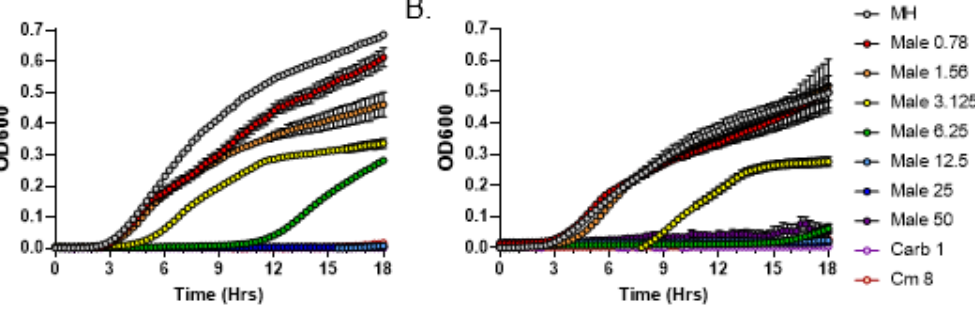
Figure 2. Broth microdilution method to determine the Minimal Inhibitory Concentration (MIC) of metabolites present in C. purpureus R40 exudates. Exudates from two-week-old ( A ) and four-week-old ( B ) C. purpureus R40 strains were tested in MIC assays against S. aureus ATCC25923. Growth curve of S. aureus cells was monitored in the presence of 0.781, 1.56, 3.125, 6.25, 12.5, 25, and 50 mg/mL of exudate solution. MH—negative control, no exudate added. Carbenicillin (Carb, 1 µg/mL) and chloramphenicol (Cm, 8 µg/mL) treatments were used as positive controls for S. aureus growth inhibition.